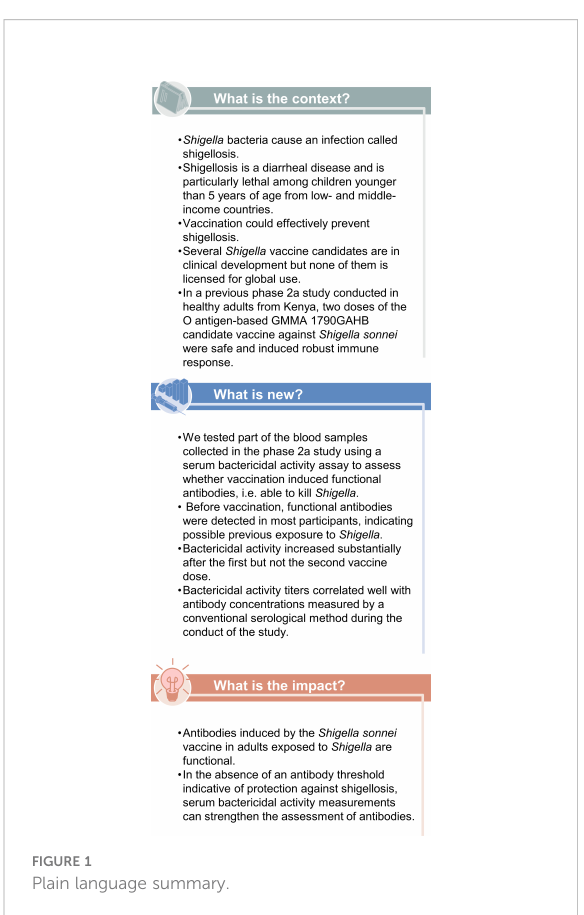
FIGURE 1 Plain language